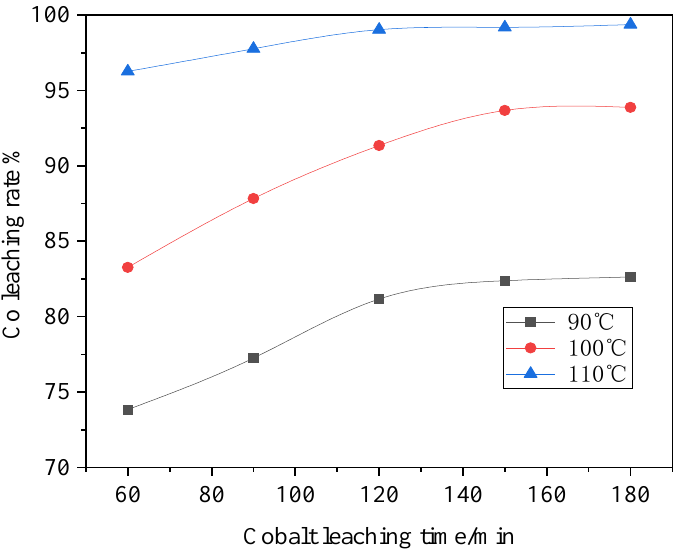
Figure 7. Effect of leaching time on Co leaching rate at different temperatures.